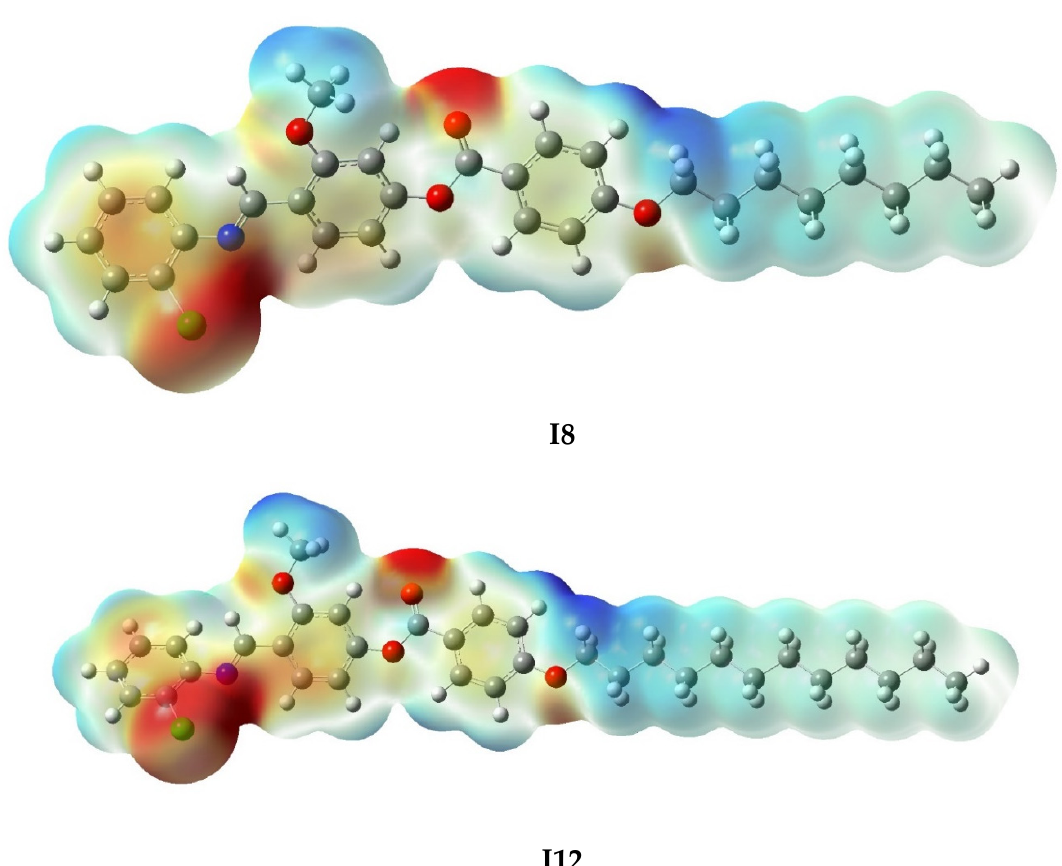
Figure 8. Frontier molecular orbital calculated at B3LYP/6-31g (d,p) for the I8 and I12 derivatives.